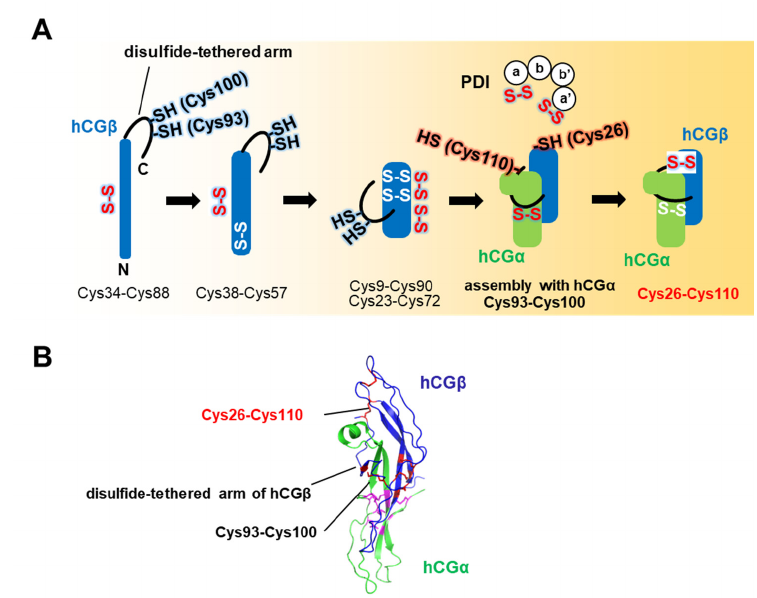
Figure 3. PDI-assisted human chorionic gonadotropin (hCG) folding and assembly. ( A ) Schematic diagram of the PDI-assisted folding and assembly pathway of hCG. After hCG assembly by PDI, Cys93-Cys100 on the arm of hCG β and Cys26-Cys110 disulfide bonds form to embrace hCG α . ( B ) Crystal structure of the hCG complex (PDB code: 1HCN). hCG α and hCG β are colored green and blue, respectively. Disulfide bonds of hCG α and hCG β are represented by magenta and red sticks, respectively. In particular, hCG α is recognized by a loose loop flanking a Cys93-Cys100/Cys26-Cys110 disulfide bond that positions hCG β .